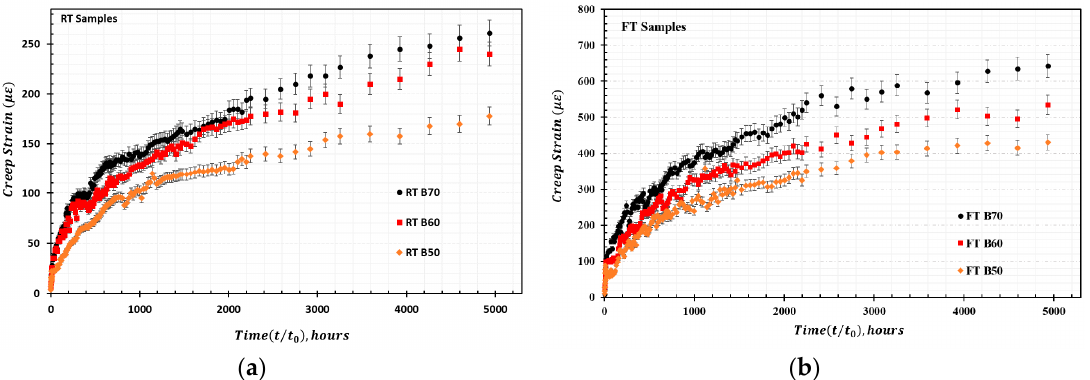
Figure 6. HFRP creep strain for samples loaded at 50–70% ultimate stress: ( a ) Creep strain for untreated RT samples; ( b ) Creep strain for freeze–thaw pretreated FT samples.